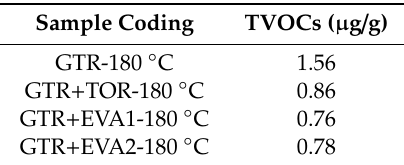
Table 9. Total volatile organic compounds (TVOCs) parameter determined for GTR and GTR modified by